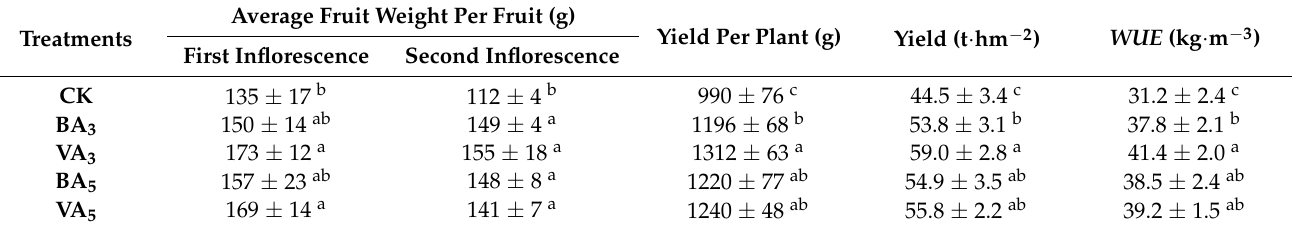
Table 4. Effects of BA and VA rates on tomato yield and water use efficiency.